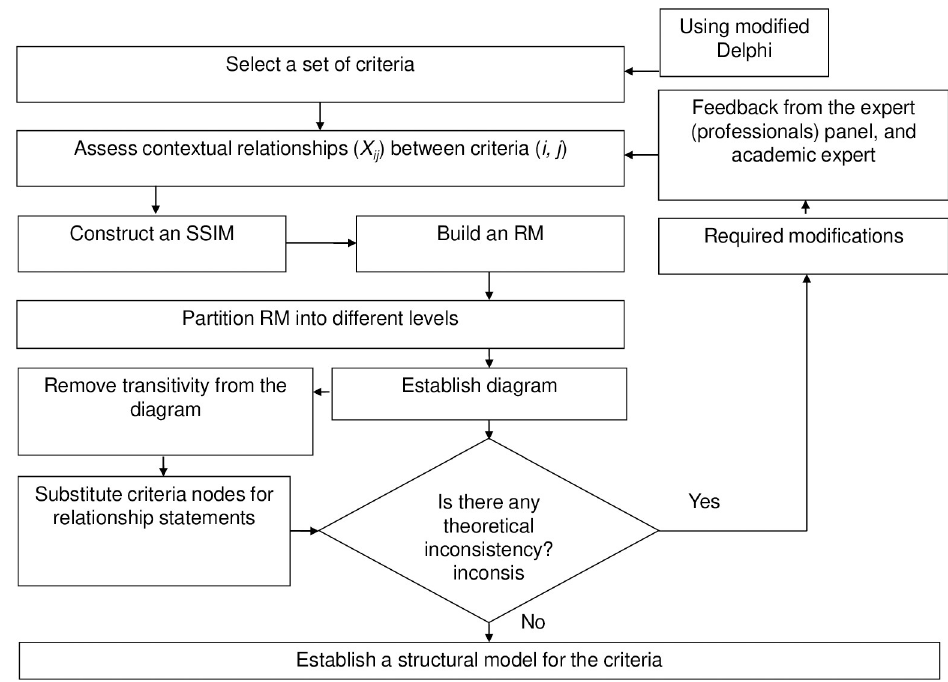
Fig 4. Flow chart for establishing the ISM